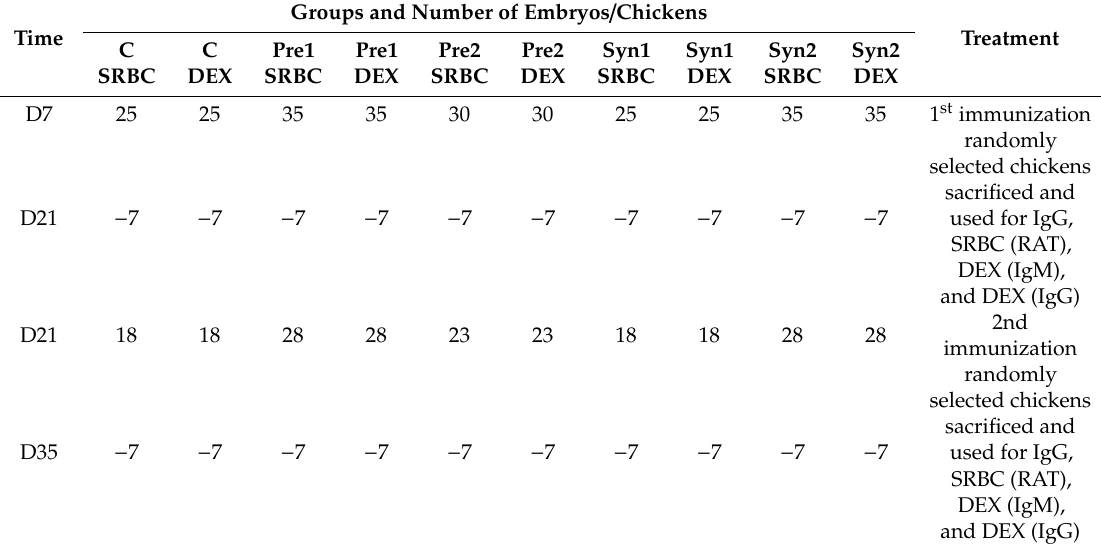
Table 2. Chickens immunized against T-dependent (SRBC) and T-independent (dextran) antigens.